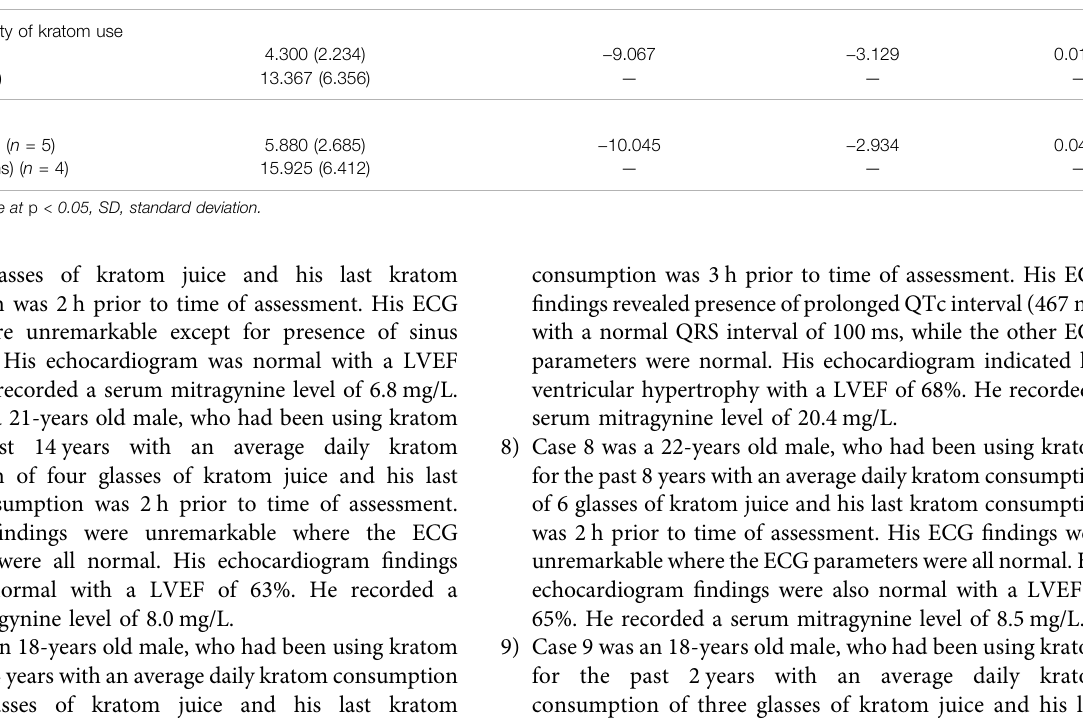
Average daily quantity of kratom use < 4 glasses ( n (cid:1) 3)